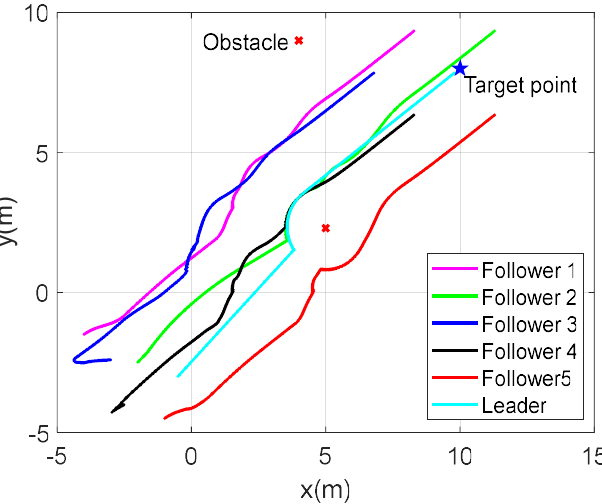
Figure 5. Motion trajectories of AGVs in a single cluster. The figure shows the trajectories of the tasks performed by each AGV.